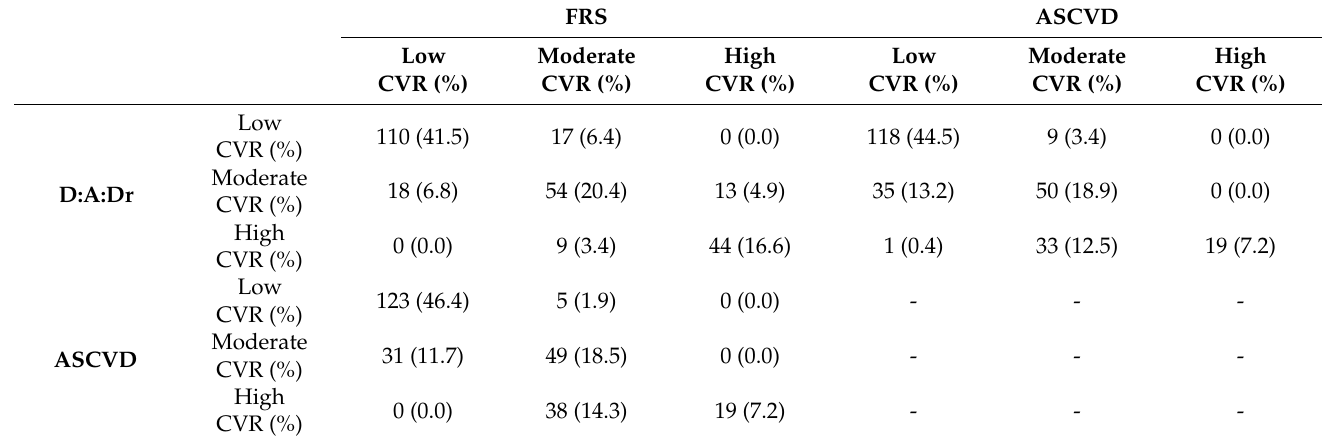
Table 3. Cross-rating between risk ratings by calculators.